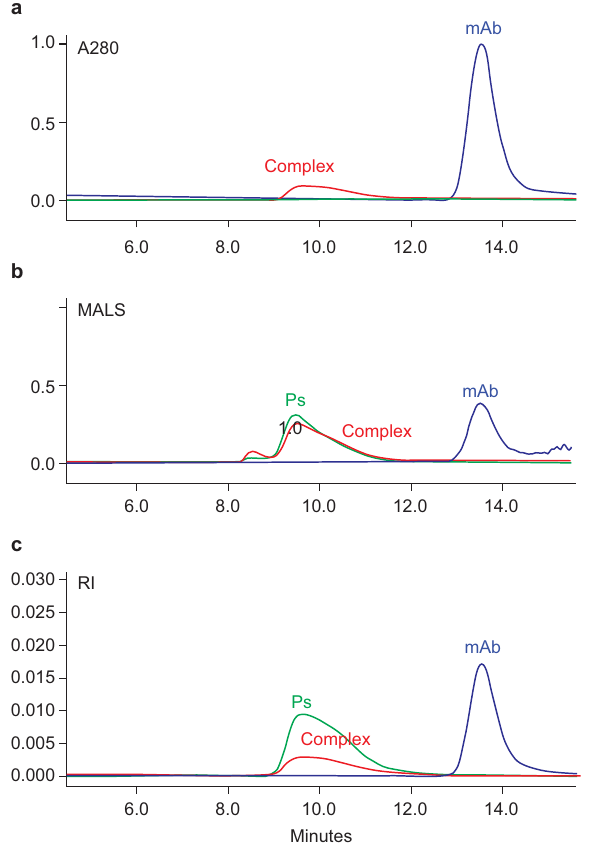
(Fig. 6a), and a linear FLR response curve was established from the polysaccharide (Ps) concentration range of 0.01 to 0.15 µg/mL (Supplementary Table 1). As Ps concentration increased above 0.15 µg/mL, the FLR response curve started to fl atten, indicating that the multi-epitopes on a polysaccharide molecular structure were no longer saturated by mAb binding at these concentrations (Fig. 6b). Furthermore, the binding reaction was probed at different time points (0.5 – 5 h), to establish a robust assay window where results would not be impacted by the binding kinetics.